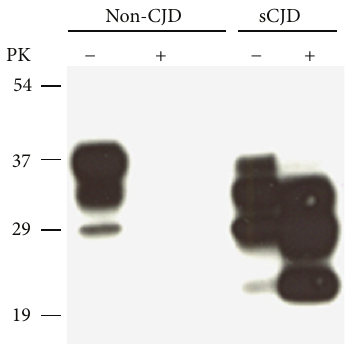
Figure 4: Detection of PK-sensitive PrP Sc . (a) Conventional Western blot of PrP treated with or without PK. No PrP was observed after PK treatment in the samples from non-CJD. The PK-resistant PrP27–30 was indicated in the sample from sCJD. Samples were digested with 50 𝜇 g/mL proteinase K for 1 hour at 37 ∘ C, completely hydrolyzing PrP 𝐶 . Proteinase digestion cleaves ∼ 90 amino acids from the amino terminus of PrP Sc to generate PrP27–30. Blot is developed with anti-PrP mouse monoclonal antibody 3F4